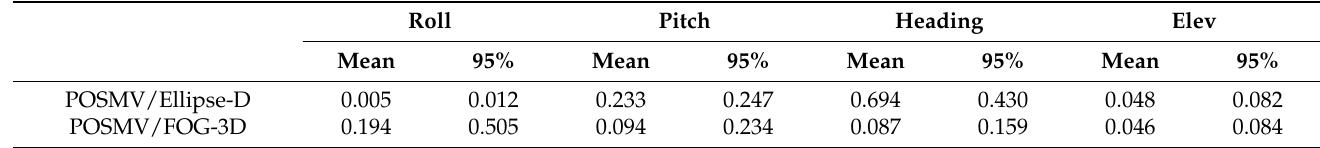
Roll Pitch Heading